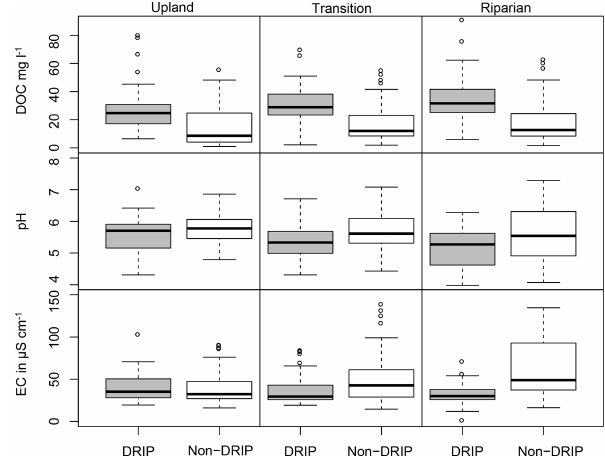
Figure 4. Groundwater chemistry gradients from upland to riparian wells. In each column DOC, pH, and EC values are presented for a location relative to the stream (riparian, transition, and upland). Within each panel, DRIP boxplots are presented in gray, and non- DRIP boxplots are shown in white.